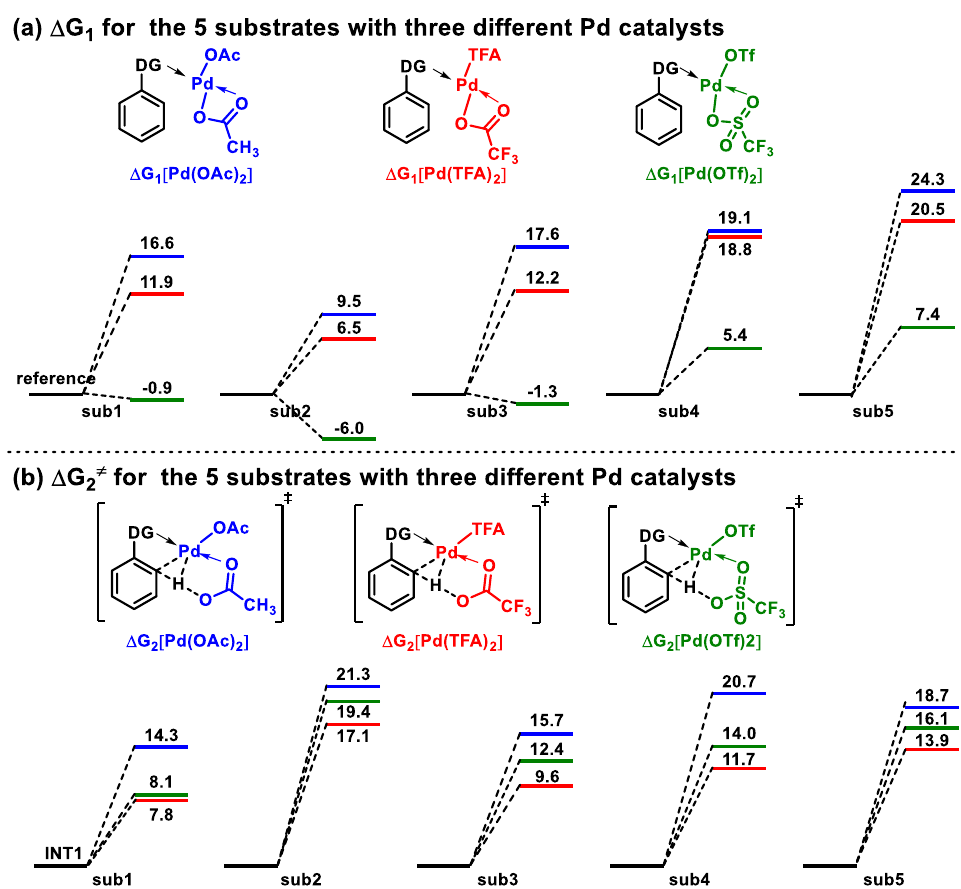
Figure 2. ( a ) ΔG 1 (kcal/mol) for the 5 substrates with three different Pd catalysts; ( b ) ΔG 2 ≠ (kcal/mol) for the 5 substrates with three different Pd catalysts.